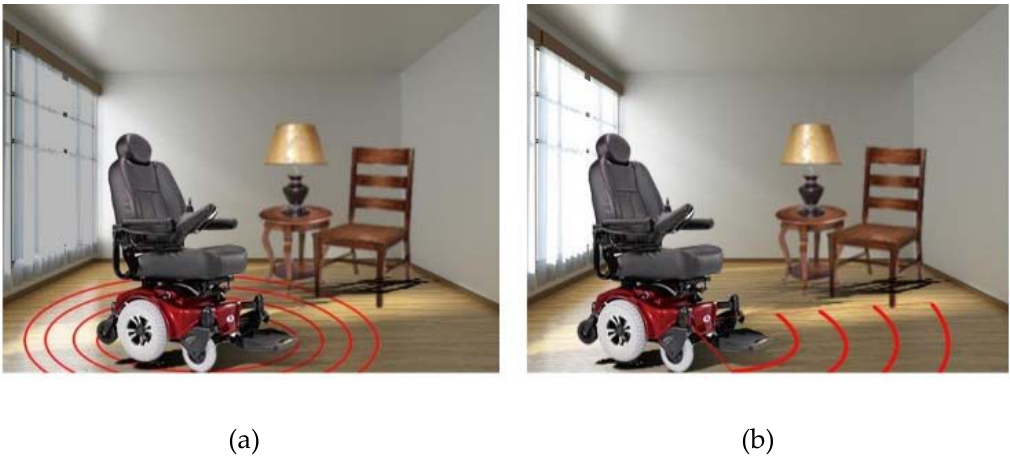
Figure 11. Proximity sensor covering range: ( a ) 360 degrees and ( b ) 120 degrees.